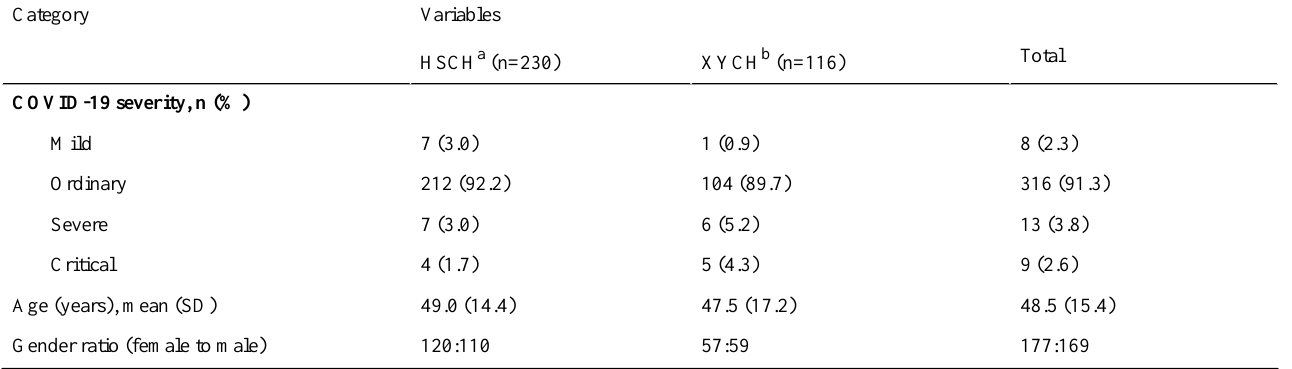
Table 1. Demographic characteristics of the patients in the 2 cohorts (N=346).